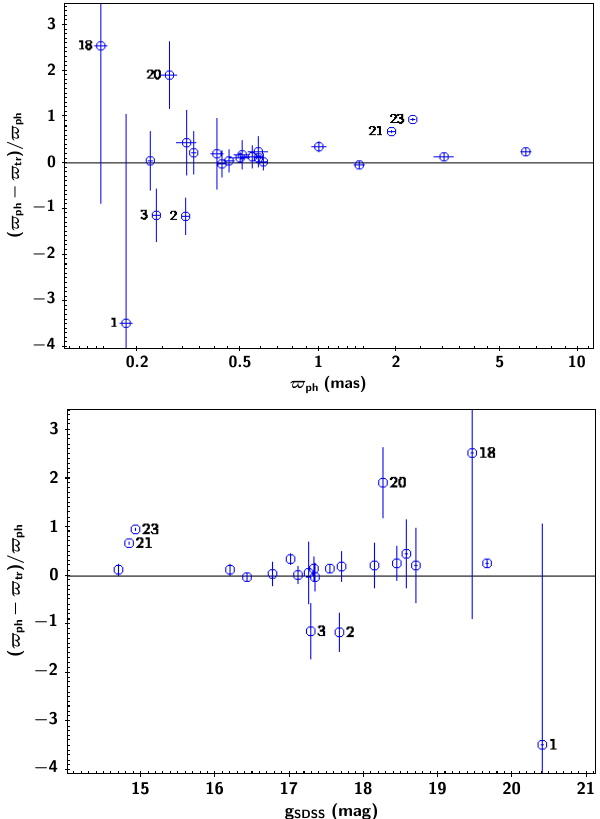
Figure 3. The ratio between the difference in parallax (cid:118) ph − (cid:118) tr and the photometric parallax (cid:118) ph vs. (cid:118) ph ( upper panel) and vs. g SDSS ( lower panel) for the stars used in Paper18 for the A V ( d ) construction. Labels correspond to running numbers of stars in Table